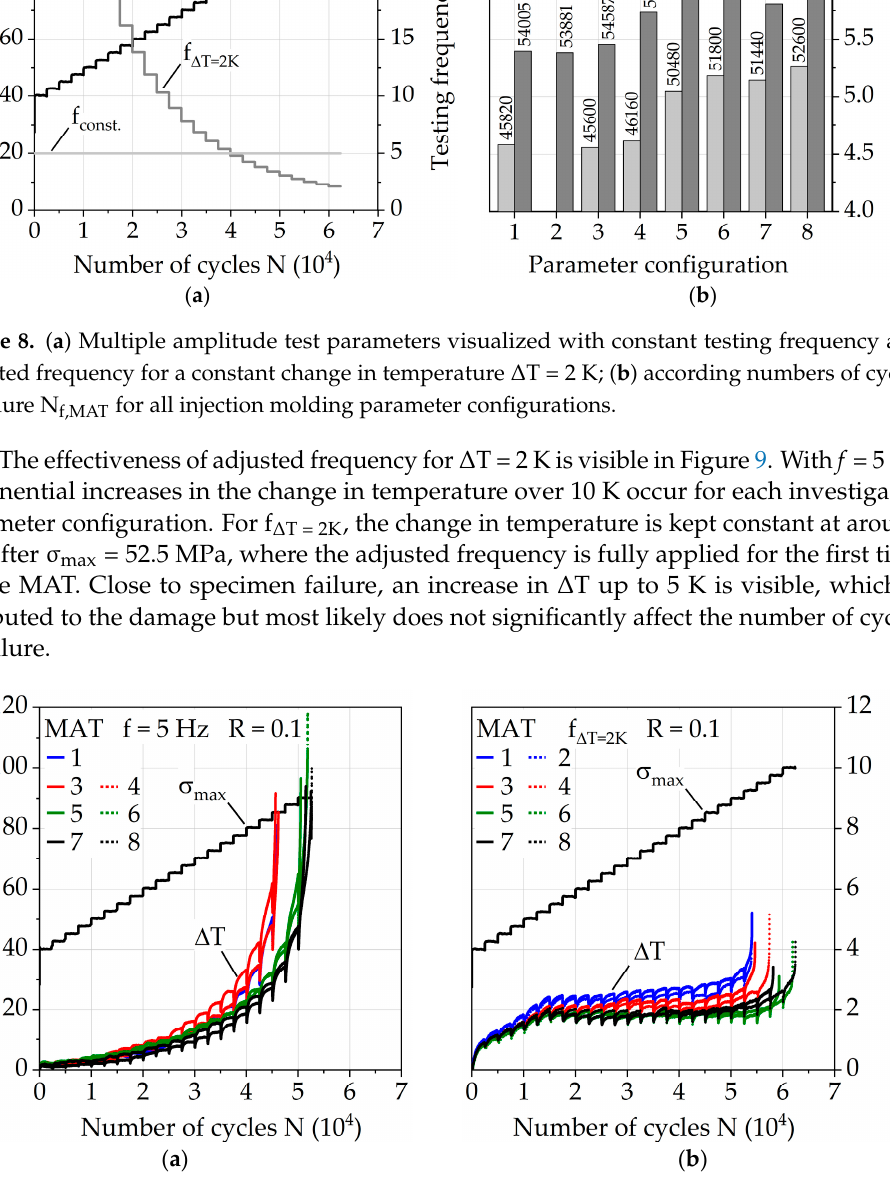
( b ) Figure 10. Normalized dynamic Young’s modulus in multiple amplitude tests with ( a ) constant testing frequency of 5 Hz and ( b ) adjusted testing frequency for a constant change in temperature Δ T of 2 K. Besides the change in temperature, the test duration also needs to be considered when interpreting the mechanical properties of PA6-GF30. Due to the use of f Δ T = 2K , which leads to higher frequencies up to σ max = 77.5 MPa of the MAT, the duration until the start of σ max = 80 MPa is 3383 s, which is nearly 60% less compared to 8000 s when using the